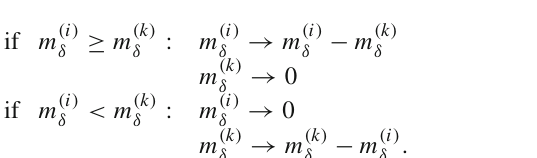
in jet transverse momentum (top left), angle (cid:2) R = √ s NN = between jet axes (top right), and relative mass difference (bottom). The mass difference is shown only for jets where the squared mass with four-momentum subtraction is